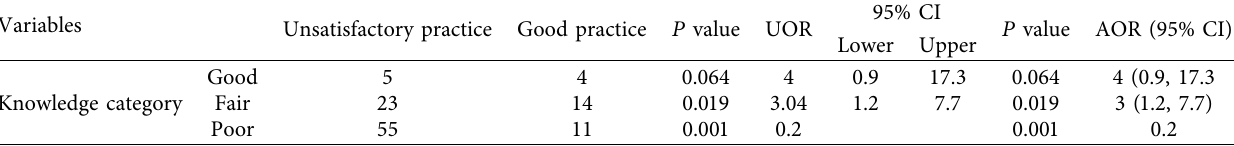
Table 8: Association between practice and knowledge regarding physical restraint use in bivariate analysis ( n � 112). Variables Knowledge category